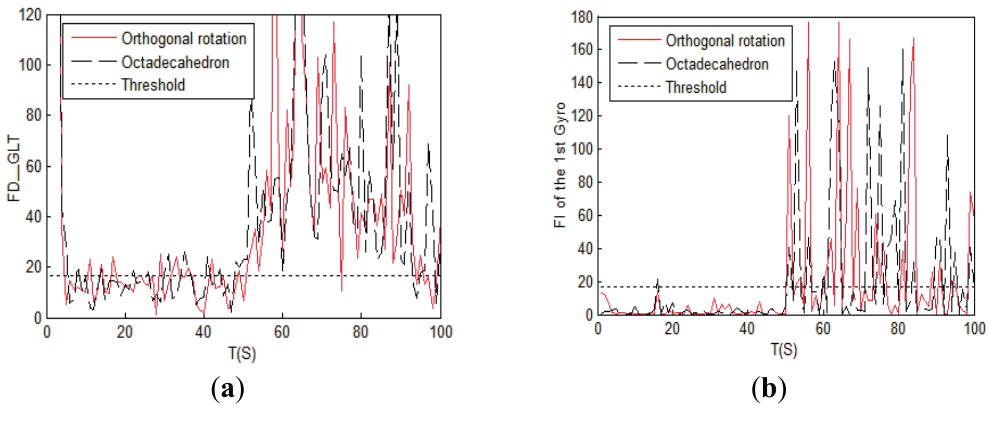
Figure 9. Single-fault detection and isolation of the octadecahedron and the orthogonal rotation configurations: ( a ) Fault judgment curves; ( b ) Fault detection curves of the 1st gyro.